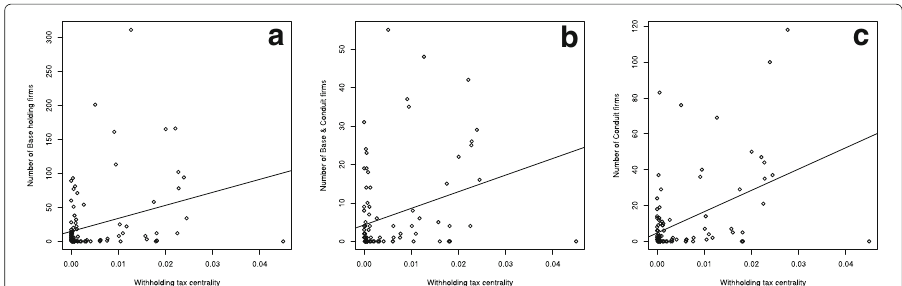
Fig. 14 Key companies and withholding tax centrality. The vertical axis indicates a number of key companies and the horizontal axis is the withholding tax centrality, which indicates the possibility to be used for treaty shopping. a Holding companies b Holding & conduit companies c Conduit